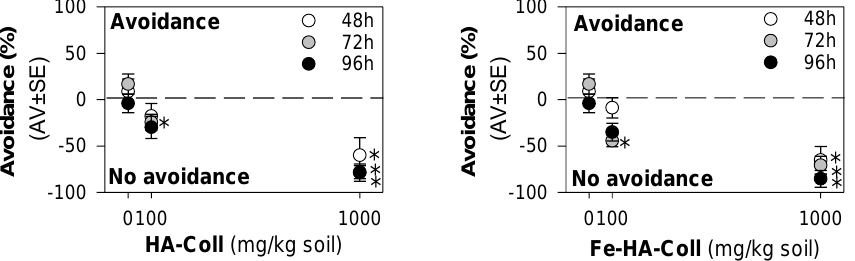
Figure 2. The results in terms of adults’ size from the Enchytraeid Reproduction Test, when expos- ing Enchytraeus crypticus in LUFA 2.2 soil to calcium hydroxyapatite (CaP-HA), superparamagnetic iron doped hydroxyapatite (Fe-HA), and titanium-doped hydroxyapatite nanoparticles (Ti-HA), and alginate/titanium-doped hydroxyapatite hybrid composite (Ti-HA-Alg), for 28 days. Values represent adults’ size (area, mm 2 ) as average ± standard error (AV ± SE). *: p < 0.05 (Dunnett ’ s method).